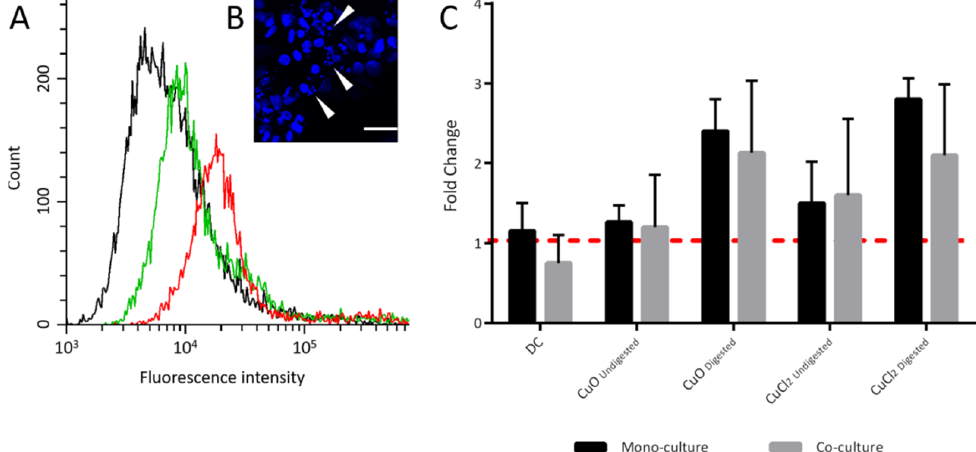
Figure 6. Detection of apoptosis induction by flow cytometry and fluorescence microscopy. ( A ) His- togram of Annexin V-FITC-stained Caco-2 mono-culture cells without (black) or with copper oxide nanoparticle (CuO-NP) treatment (green: undigested, red: digested). ( B ) DAPI-stained Caco-2 mono-culture cells after treatment with digested CuO-NP (white arrows indicate shrunken nuclei). ( C ) Fold change of apoptotic cells after treatment of Caco-2 mono- and Caco-2/HT29-MTX co-cultures with undigested and digested CuO-NP (1.3 × 10 − 3 M) or copper chloride (1.3 × 10 − 3 M). The samples were normalized to the untreated negative control (red line). All samples are means of three independent replicates and were measured in triplicate. DC: digestive control (10% digestive juice).